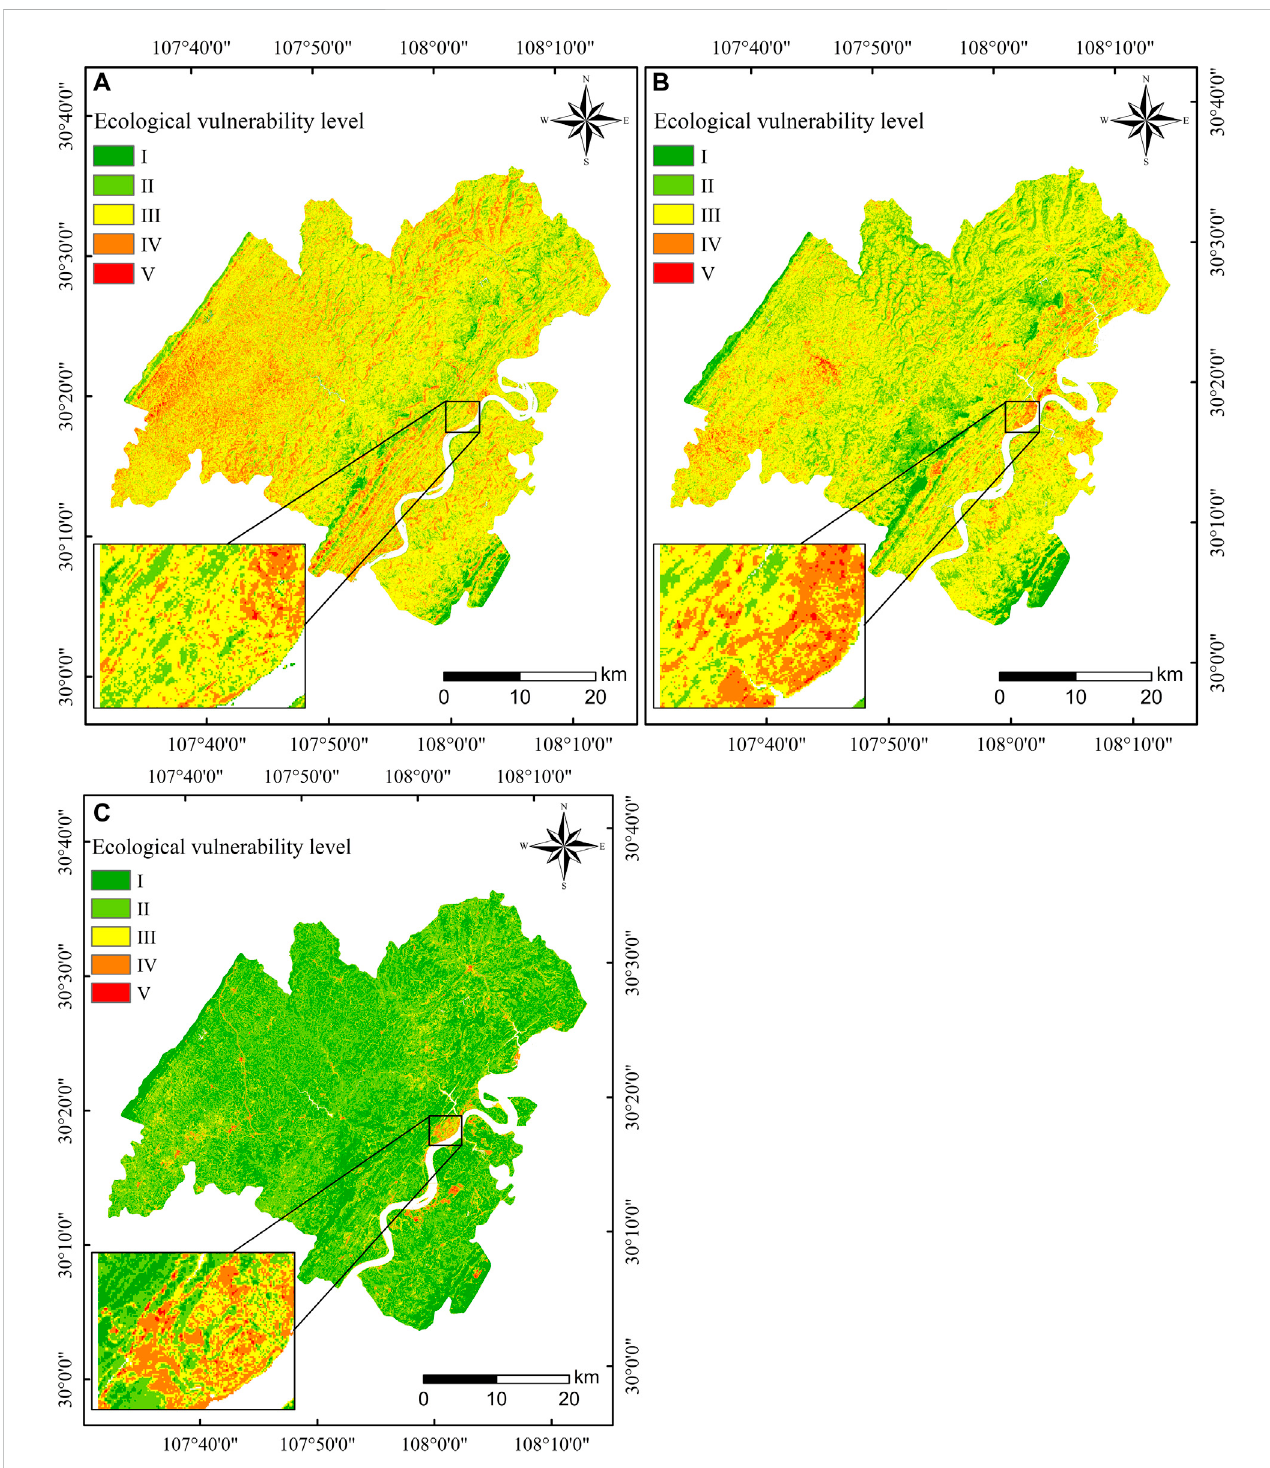
FIGURE 3 SpatialdistributionofecologicalvulnerabilitylevelinZhongxianCountyin2002 (A) ,2009 (B) and2016 (C) (waterbodymasktreatment,thepictureatthe lower left corner shows the location of Zhongxian administrative